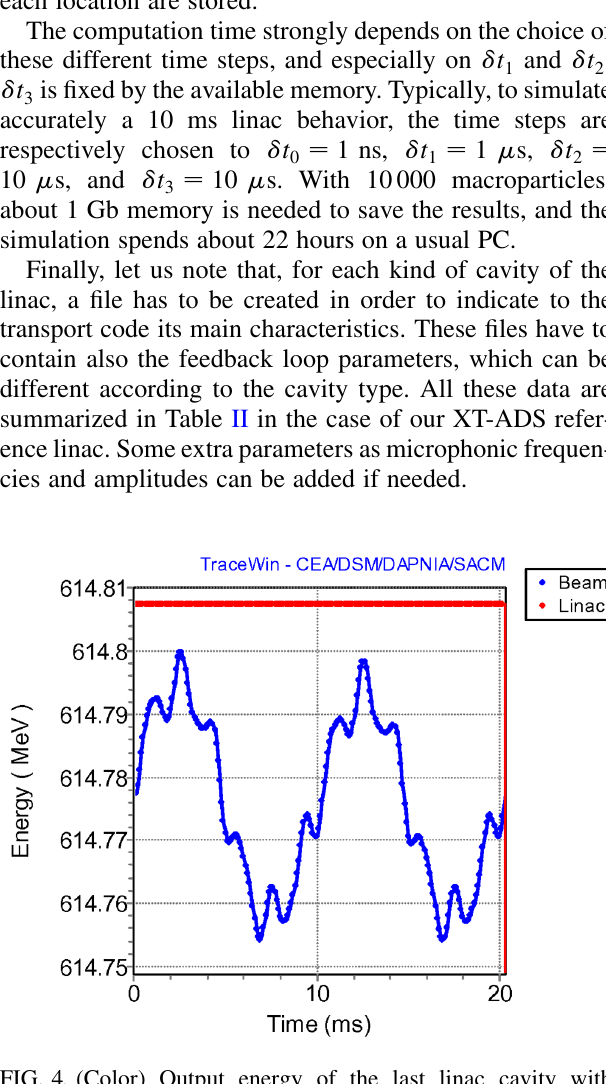
FIG. 4. (Color) Output energy of the last linac cavity with microphonics perturbations.